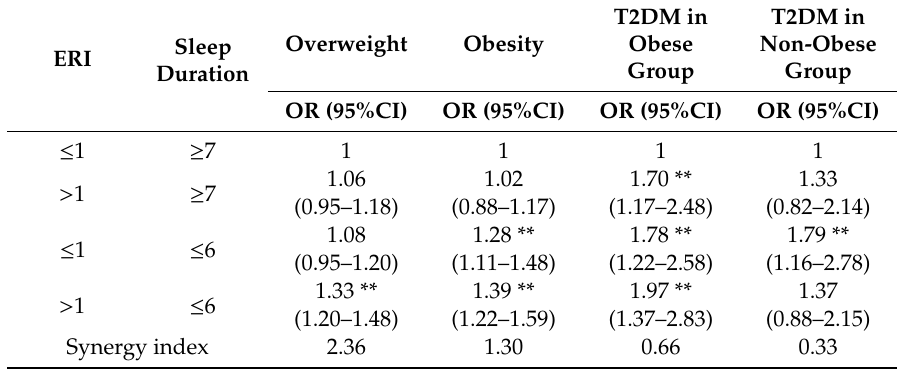
Table 7. Interaction e ff ect of ERI and sleep duration during the workday on overweight / obesity and T2DM using multiple logistic regression after adjusting for age, gender, education level, marital status, and smoking and alcohol